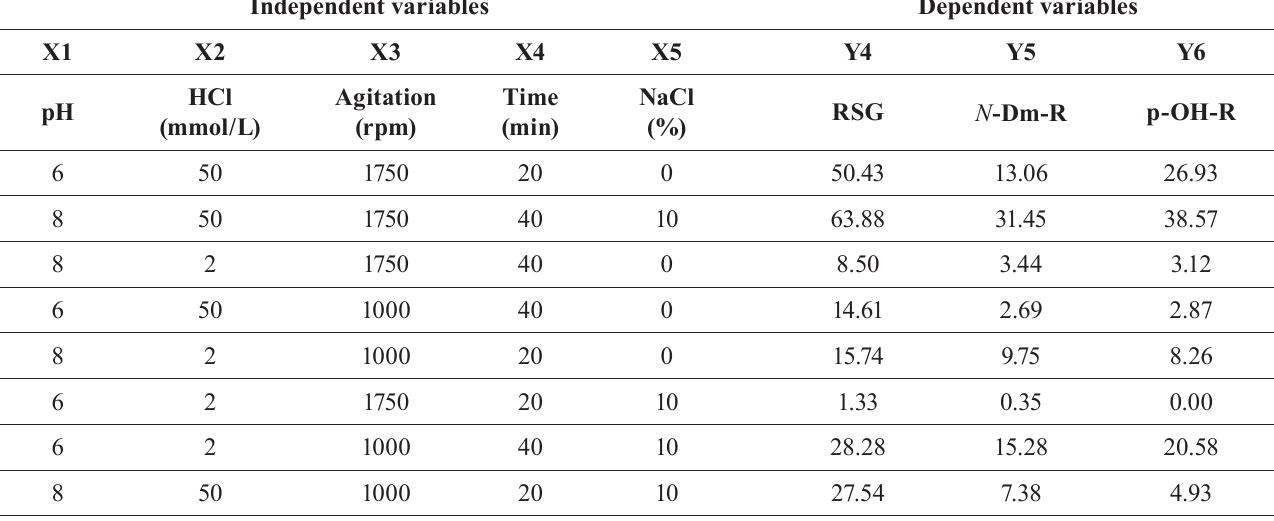
TABLE II - Independent (X1, X2, X3, X4, and X5) and recovery factor extraction (%) - dependent variables (Y4, Y5, and Y6), fractionate factorial design matrix, and results of experimental design for rosiglitazone (RSG) and its metabolites ( N -Dm-R and